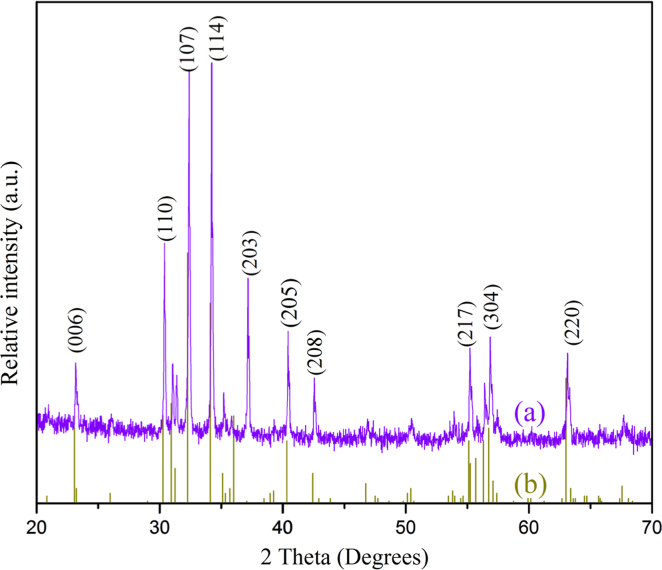
Structure identification of La0.2Pb0.7Fe12O19. (a) XRD pattern of the La0.2Pb0.7Fe12O19 with O2 annealing process. (b) The standard diffraction pattern of the PbFe12O19 compound (PDF#15–0623) being marked by red discrete lines. (For interpretation of the references to color in this figure legend, the reader is referred to the web version of this article).